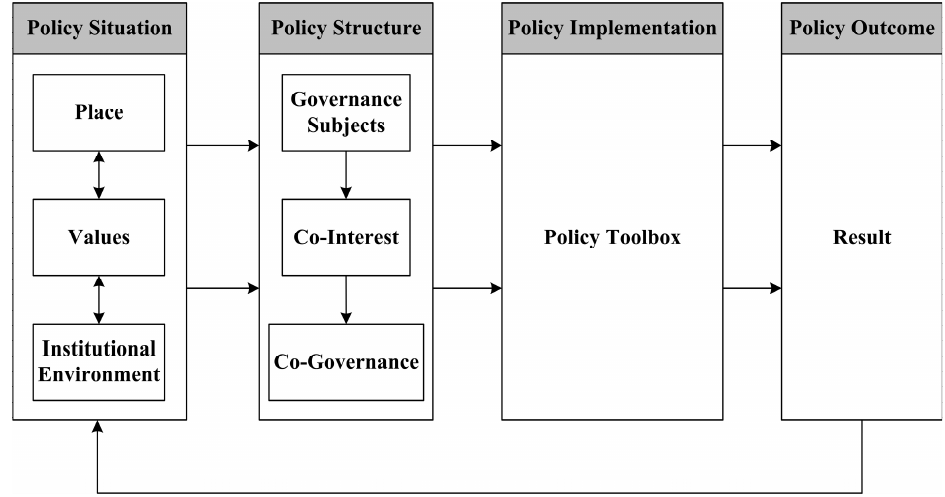
Figure 8. SSIO: a policy process analysis framework.